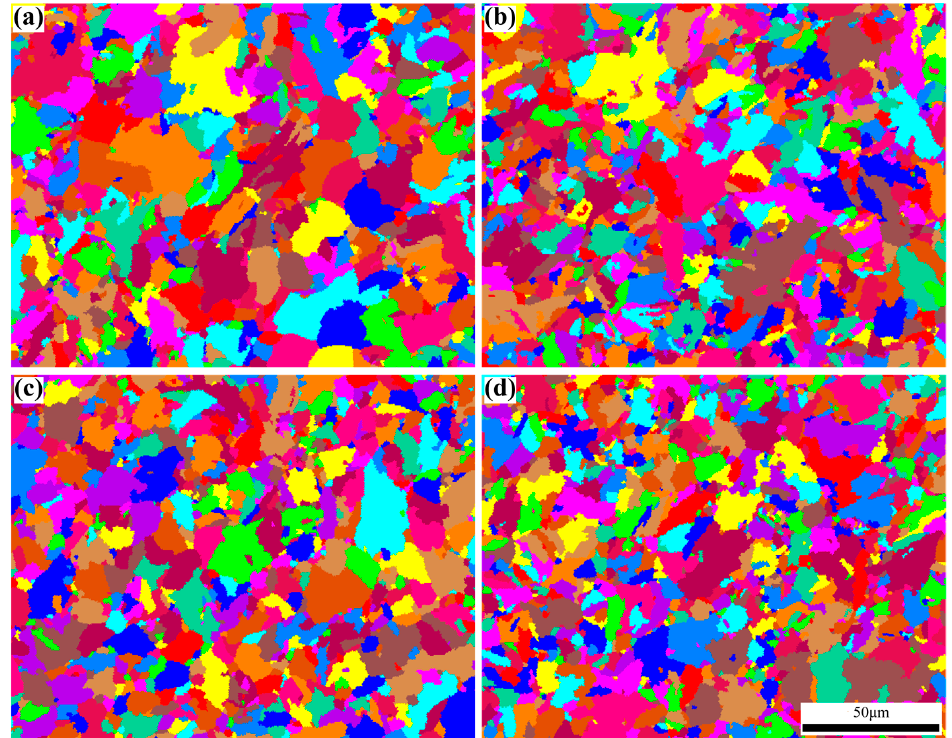
Figure 2. EBSD maps of the specimens after different hot rolling reductions: ( a ) HR ‐ 1; ( b ) HR ‐ 2; ( c ) HR ‐ 3; ( d ) HR ‐ 4.